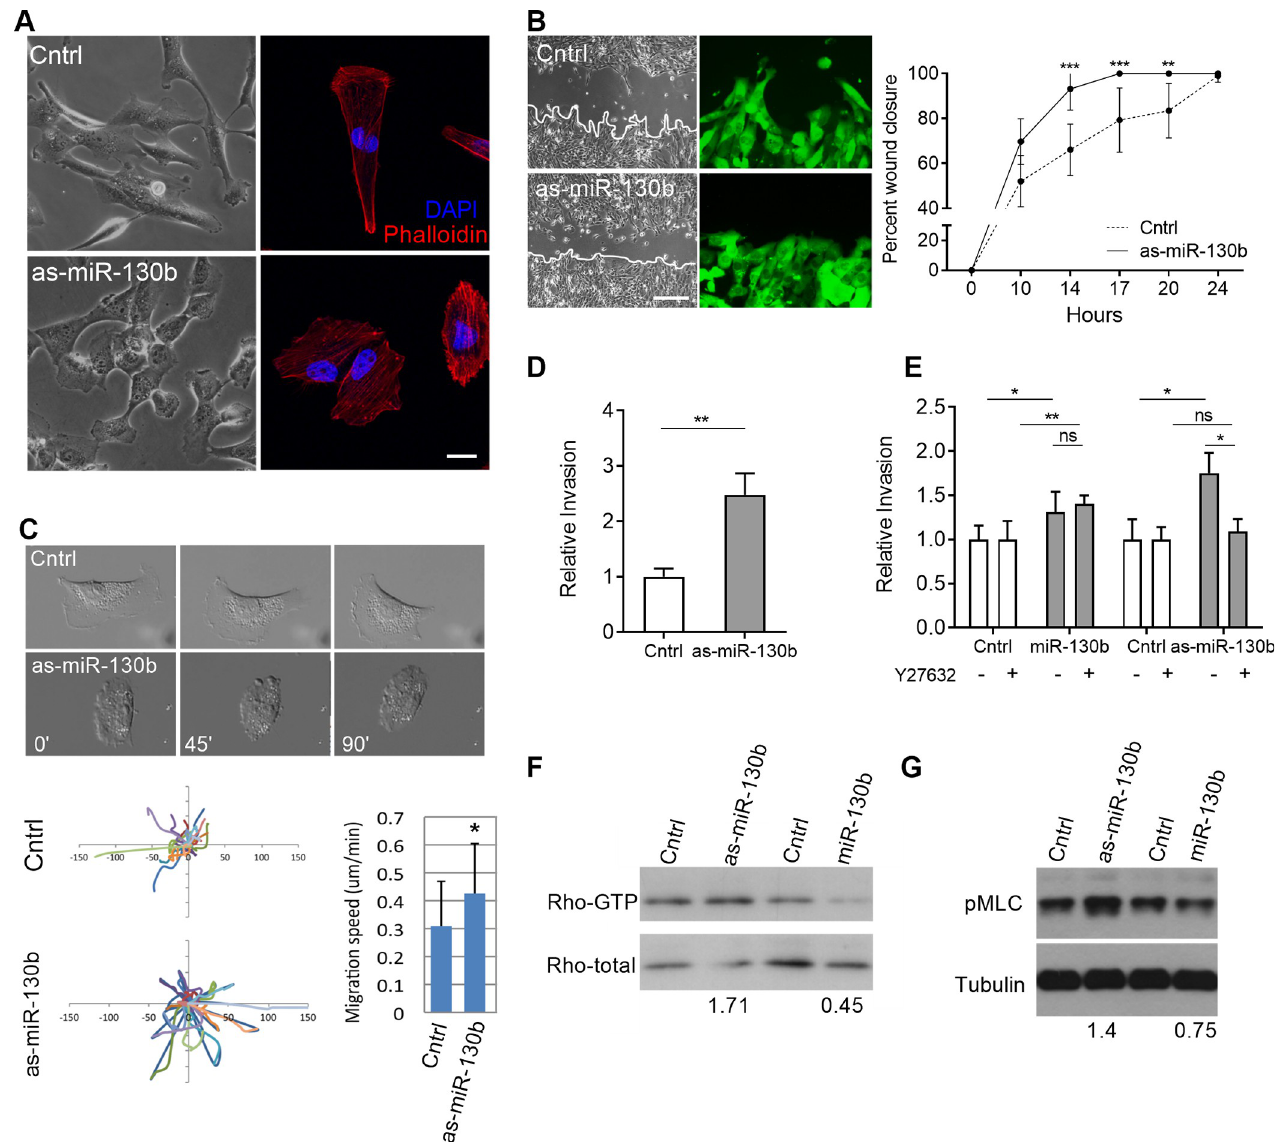
Fig 5. MiR-130b levels regulate LMS cell morphology, migratory and invasive behavior and Rho signaling. (A) Representative bright field ( left panels ) and immunofluorescence ( right panels , red = phalloidin, blue = DAPI) images of LMS cells transduced with the anti-sense sequence of miR-130b (as-miR-130b) or control vector (Cntrl). Scale bar: 20 μ m. (B) Scratch assay of control and as-miR-130b transduced LMS1 cells showing percentage of wound closure (relative to t = 0) over 24 h (n = 3). Representative bright field and fluorescent images ( left panels ) of scratch area showing prevalent leading-edge protrusions in control but not as-miR-130b transduced cells (arrowheads). Scale bar: 100 μ m (C) Still images of time-lapse video microscopy of control and as-miR-130b transduced cells ( upper panels ), depicting a loss of lamellipodia and elongated cell morphology following miR-130b inhibition. Track plots indicating migration paths of individual cells (n = 25) from a single origin (center of axes) in control and as-miR-130b groups ( bottom panel , left ). Average migration speed ( bottom panel , right ) calculated by Image J. (D) Transwell assay showing relative invasion of as-miR-130b and control transduced LMS1 cells after 18 h. Cells were counted on membrane inserts after crystal violet staining. Cell counts were normalized to the control group. (E) Transwell assays showing relative invasion in the absence (-) or presence (+) of the ROCK inhibitor Y27632 (ROCKi). All invasion assays were performed in triplicate. Cell counts were normalized to the control groups without Y27632. (F) Rho-GTP levels in LMS1 cells by pull down assay following miR-130b down-regulation (as-miR-130b) and overexpression (miR-130b) relative to controls. Numbers indicate relative Rho-GTP band intensities of as-miR-130b and miR-130b groups versus control groups after normalization to total Rho levels. (G) Immunoblot of pMLC and tubulin in corresponding cell cultures. Numbers indicate relative pMLC band intensities of as-miR-130b and miR-130b groups versus control groups after normalization to tubulin levels. Statistical analyses were performed by two-tailed students t-test; � P < 0.05, �� P < 0.005, ��� P <